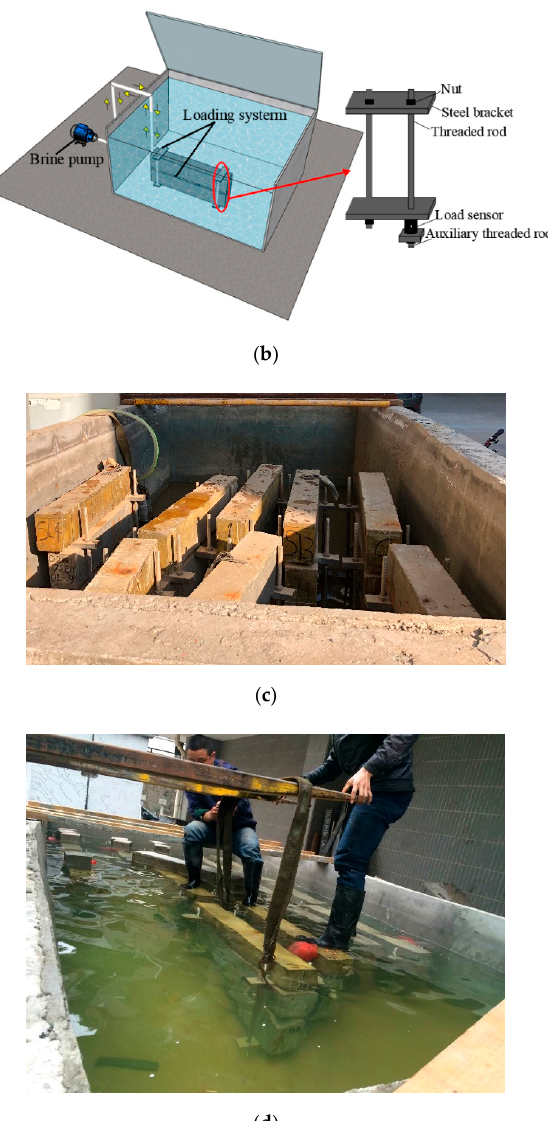
Figure 3. Loading system and exposure conditions. ( a ) Loading system (mm); ( b ) Exposure conditions; ( c ) Drying stage; ( d ) Wetting stage.